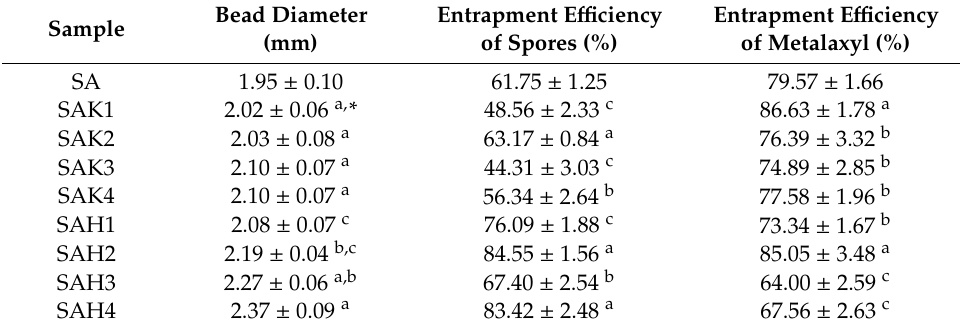
Table 2. Characteristics of starch–alginate